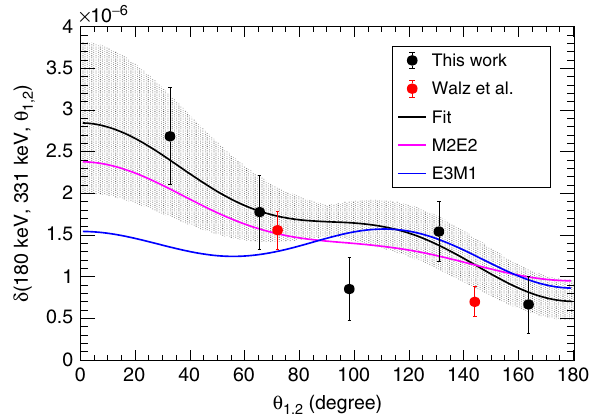
Fig. 4 Angular distribution. The angular correlation of the two photons emitted in the double- γ decay from this work and reference 11 , compared with the expected angular distributions of pure M2E2 and E3M1 decay. The error bars represent the one standard-deviation statistical uncertainty.